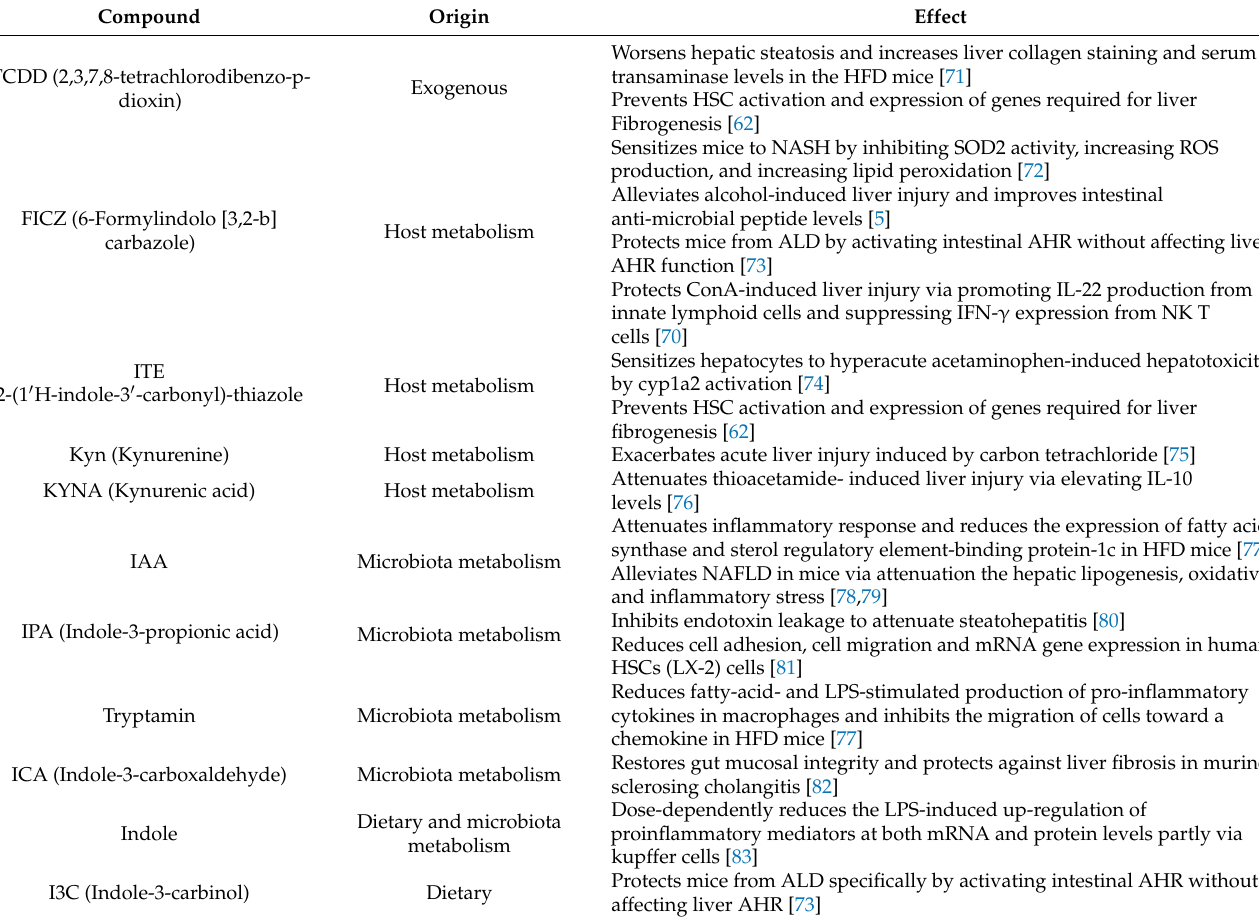
Table 2. The role of AHR ligands in liver